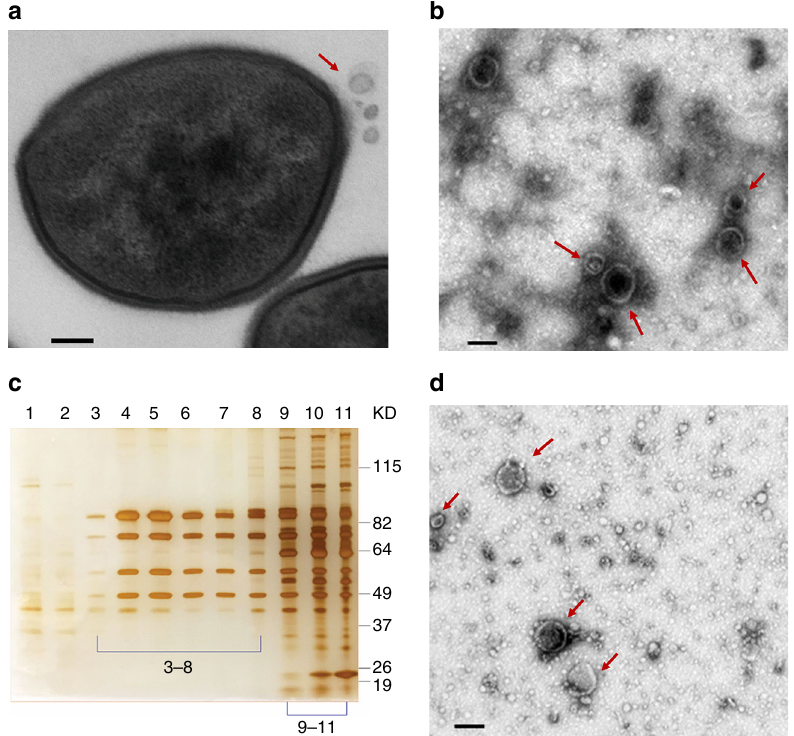
Fig. 1 Extracellular vesicles from S aureus JE2. The bacteria were cultivated in TSB. a Ultrathin sections of S. aureus JE2 examined by TEM revealed EVs (indicated by a red arrow) released from the cell wall. b Crude EVs (red arrows) pelleted by ultracentrigation from the JE2 culture supernatant were imaged by TEM. c EVs were puri fi ed by density gradient ultracentrifugation (Optiprep), and fractions were visualized by silver-stained SDS-PAGE. d Fractions 3 – 8 were pooled; OptiPrep was removed by dia fi ltration, and the samples were imaged by TEM. EVs were not visualized in fractions 9 – 11. Scale bar, 100